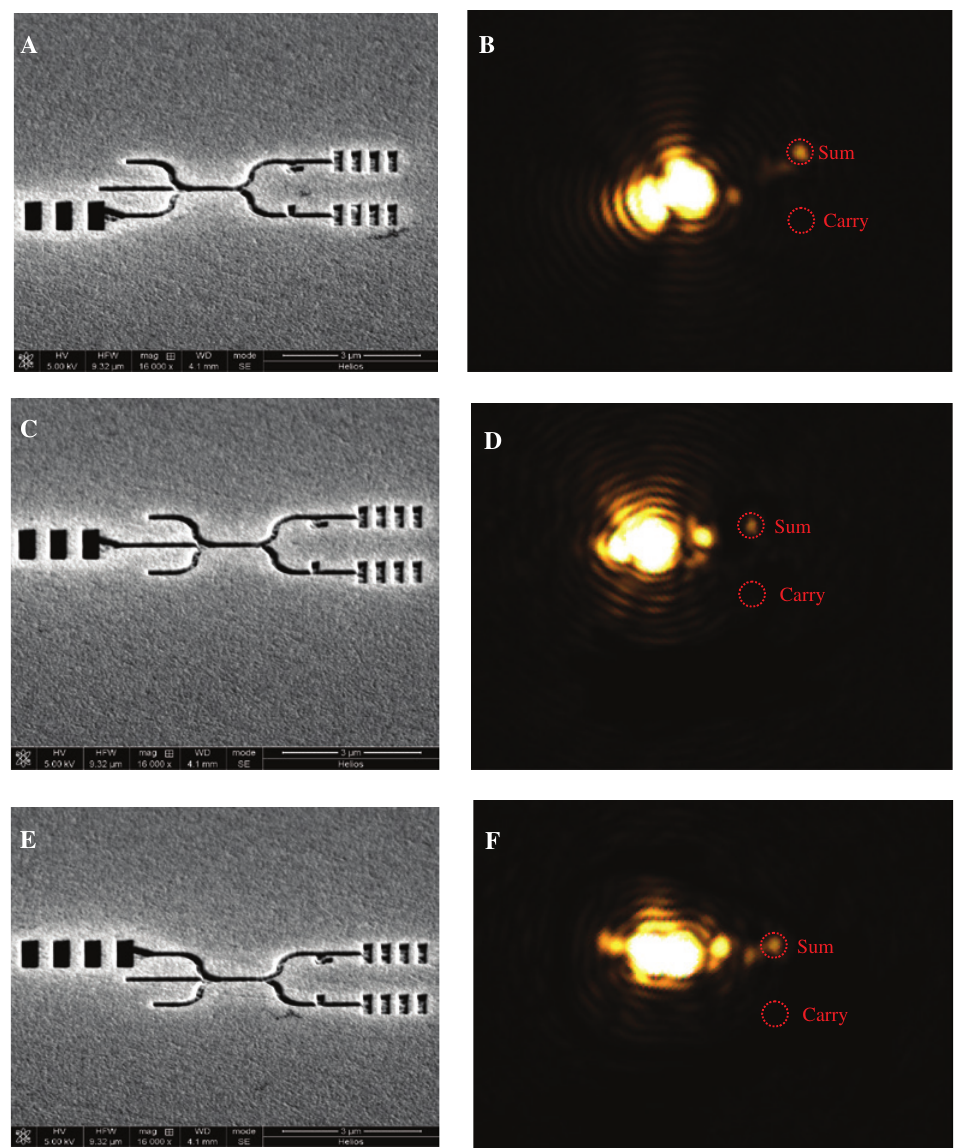
Figure 4: Performances of the logic function of the full-adder sample. The SEM image (A) of the full-adder sample without the nano- Au:(IR140:MEH-PPV) cover layer and the measured CCD image (B) of the full-adder sample having the nano-Au:(IR140:MEH-PPV) cover layer under excitation of a 770-nm, 120-fs laser for the logic operation of “0” + “0” + “1” = (Sum “1”, Carry “0”). The SEM image (C) of the full-adder sample without the nano-Au:(IR140:MEH-PPV) cover layer and the measured CCD image (D) of the full-adder sample having the nano- Au:(IR140:MEH-PPV) cover layer under excitation of a 770-nm, 120-fs laser for the logic operation of “0” + “1” + “0” = (Sum “1, Carry “0”). The SEM image (E) of the full-adder sample without the nano-Au:(IR140:MEH-PPV) cover layer and the measured CCD image (F) of the full-adder sample having the nano-Au:(IR140:MEH-PPV) cover layer under excitation of a 770-nm, 120-fs laser for the logic operation of “0” + “0” + “1” = (Sum “1”, Carry “0”). The SEM image (G) of the full-adder sample without the nano-Au:(IR140:MEH-PPV) cover layer and the measured CCD image (H) of the full-adder sample having the nano-Au:(IR140:MEH-PPV) cover layer under excitation of a 770-nm, 120-fs laser for the logic operation of “1” + “1” + “0” = (Sum “0”, Carry “1”). The SEM image (I) of the full-adder sample without the nano-Au:(IR140:MEH-PPV) cover layer and the measured CCD image (J) of the full-adder sample having the nano-Au:(IR140:MEH-PPV) cover layer under excitation of a 770-nm, 120-fs laser for the logic operation of “1” + “0” + “1” = (Sum “0”, Carry “1”). The SEM image (K) of the full-adder sample without the nano-Au:(IR140:MEH-PPV) cover layer and the measured CCD image (L) of the full-adder sample having the nano-Au:(IR140:MEH-PPV) cover layer under excitation of a 770-nm, 120-fs laser for the logic operation of “0” + “1” + “1” = (Sum “0”, Carry “1”). The SEM image (M) of the full-adder sample without the nano-Au:(IR140:MEH-PPV) cover layer and the measured CCD image (N) of the full-adder sample having the nano-Au:(IR140:MEH-PPV) cover layer under excitation of a 770-nm, 120-fs laser for the logic operation of “1” + “1” + “1” = (Sum “1”, Carry “1”). Calculated linear transmission spectrum of the plasmonic waveguide side-coupled the plasmonic nanocavity C3 (O) or C4 (P) having the nano-Au:(IR140:MEH-PPV) cover layer under different excitation cases. Circles indicate which points shift to the position of 770